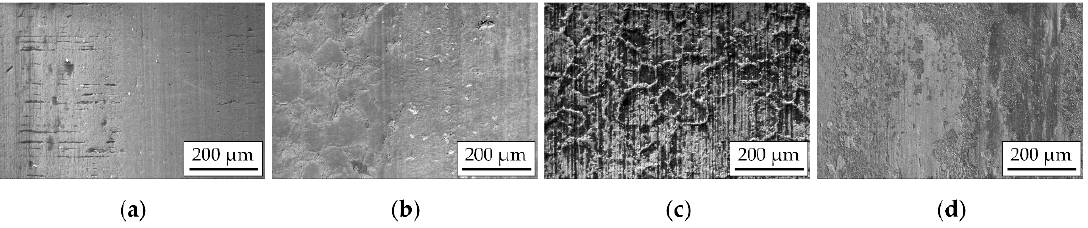
Figure 15. SEM images of wear tracks after friction with UHMWPE; untreated titanium ( a ), nitrided samples at 750 °C ( b ) and 900 °C ( c ), and borided sample ( d ).